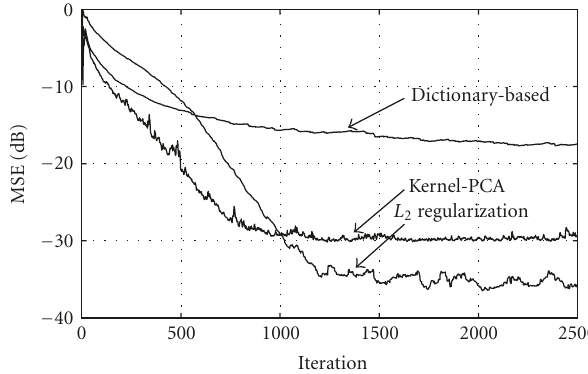
Figure 8: MSE e 2 [ n ] on the Wiener system’s internal signal r [ n ] r for adaptive kernel CCA-based identification of a static noiseless Wiener system.